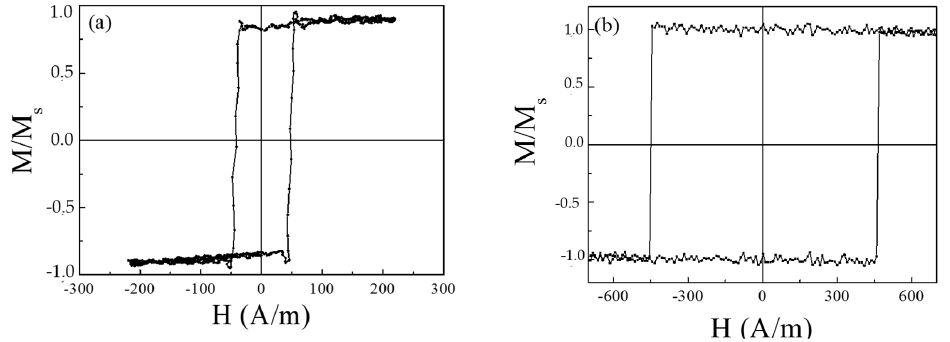
Figure 3. Hysteresis loops of as-prepared Fe 70.8 Cu 1 Nb 3.1 Si 16 B 9.1 microwires with ρ = 0.62 ( a ) and as-prepared Fe 38.5 Co 38.5 B 18 Mo 4 Cu 1 with ρ = 0.60 ( b ). Reproduced from reference [10], Figure 5.